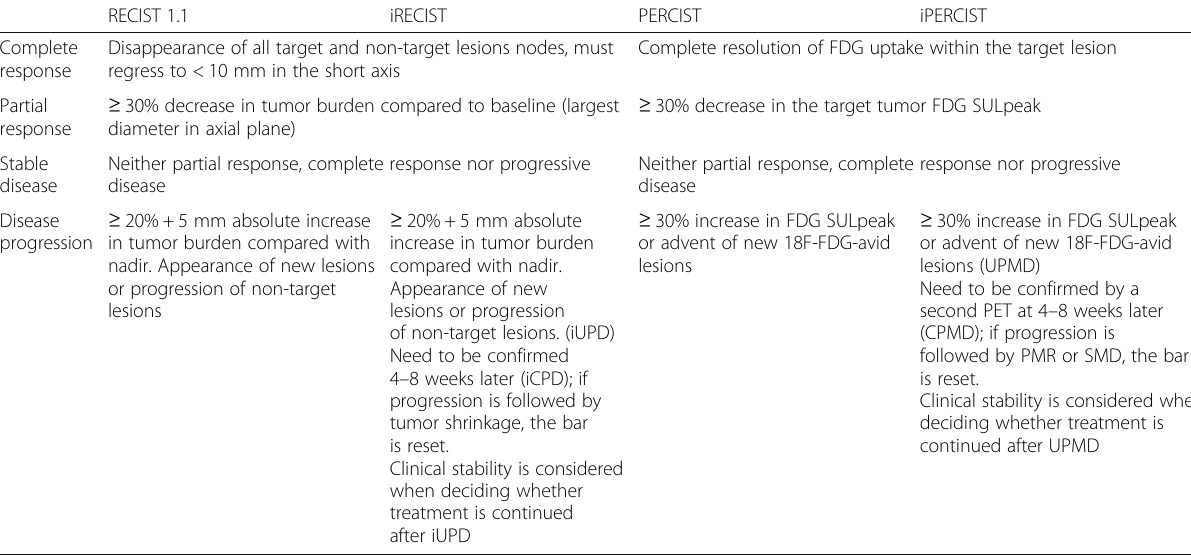
Table 1 Comparison of RECIST 1.1, iRECIST, PERCIST, and iPERCIST criteria for immunotherapy evaluation RECIST